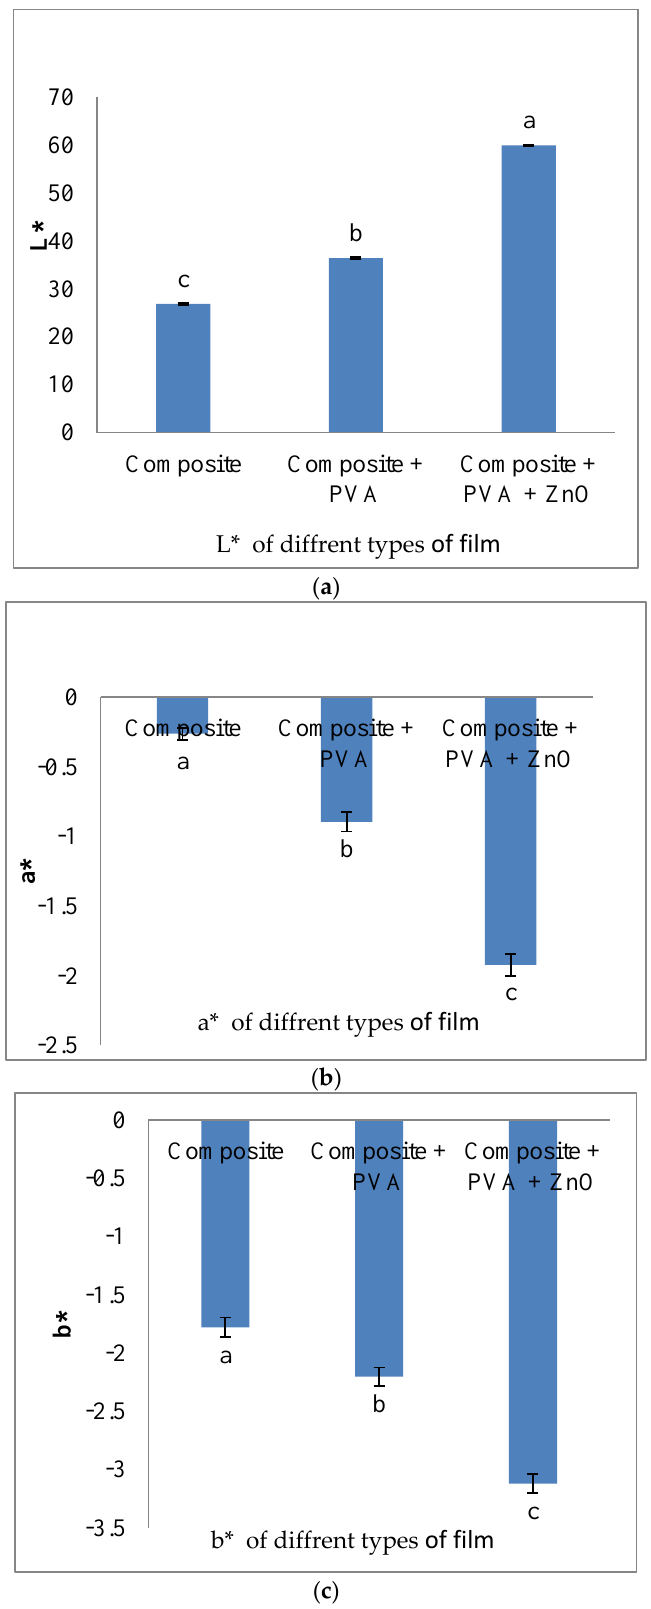
Figure 4. ( a – c ) Color profiling of different types of films. Means with different superscripts a–c differs significantly ( p < 0.05).